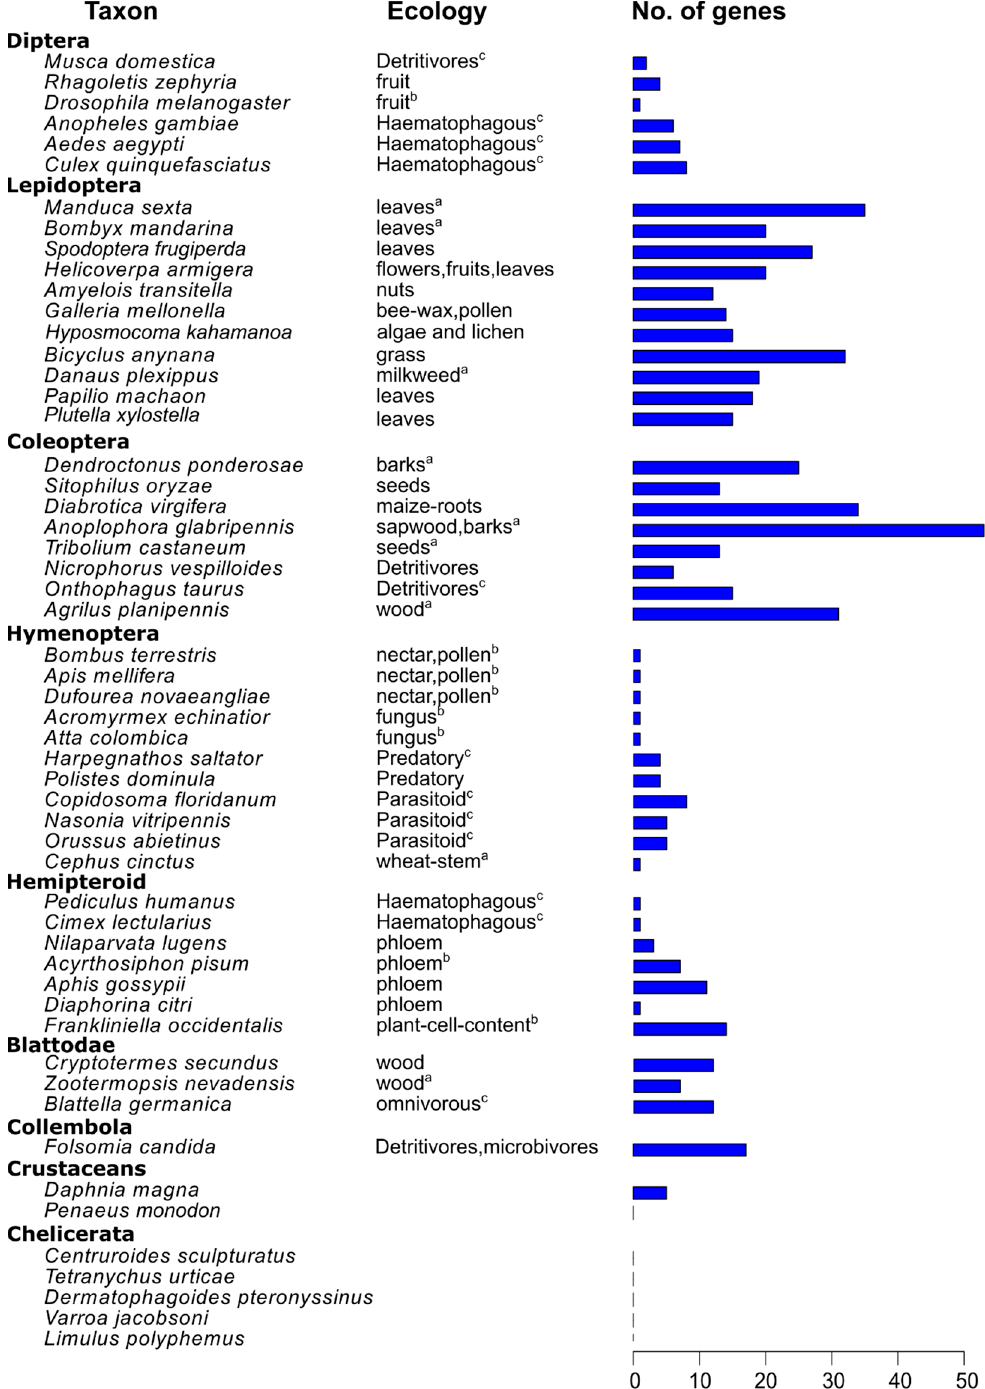
Figure 1. The feeding ecology and the number of identified GH1 genes in selected insects and other arthropods. Insect feeding ecology is indicated as their feeding types or feeding parts in plants. Blue bars represent the identified gene numbers. The species with labels were used for further phylANOVA analysis to compare the gene numbers between labeled groups, which was presented in Results; a: herbivores, direct feeding on plant cell walls; b: herbivores, non-direct feeding on plant cell walls; c: non-herbivores.